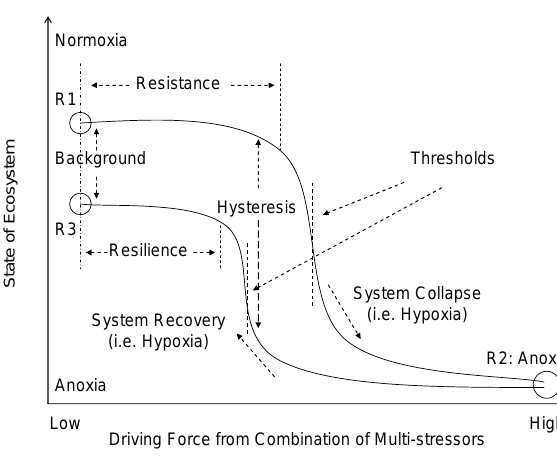
Fig. 6. Conceptual diagram for the response of ecosystems to the Figure 6. conditions of dissolved oxygen in the coastal ocean, along the tra- jectories of normoxia to hypoxia/anoxia and vice versa, with hy- poxia as transitional state. In the figure R1, R2 and R3 represent different regime states of the ecosystem that can change from one to another. In most cases, the ecosystem is affected by a combina- tion of multi-stressors with specific regional nature rather than by any single forcing, and the system response is not linear. The re- sistance, hysteresis, threshold, resilience and change in background conditions are characters that dictate the response processes of the ecosystem to the external forcing and/or pressure (e.g. either natu- ral and/or anthropogenic, or both), which is usually very dynamic in the coastal environment. When the system response passes over a threshold (e.g. from R1 to R2), a new ecosystem regime can be reached (i.e. regime shift); in the case of relief from external stres- sors, the recovery of the ecosystem will follow another pathway and eventually, can have a different background situation (i.e. R3). The figure is a modification based on the work by Tett et al., 2007, van de Koppel et al., 2009, and Kemp et al.,